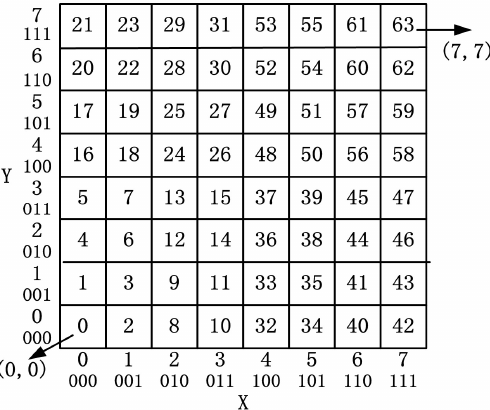
Figure 2. The M code of the expanding monitoring area.